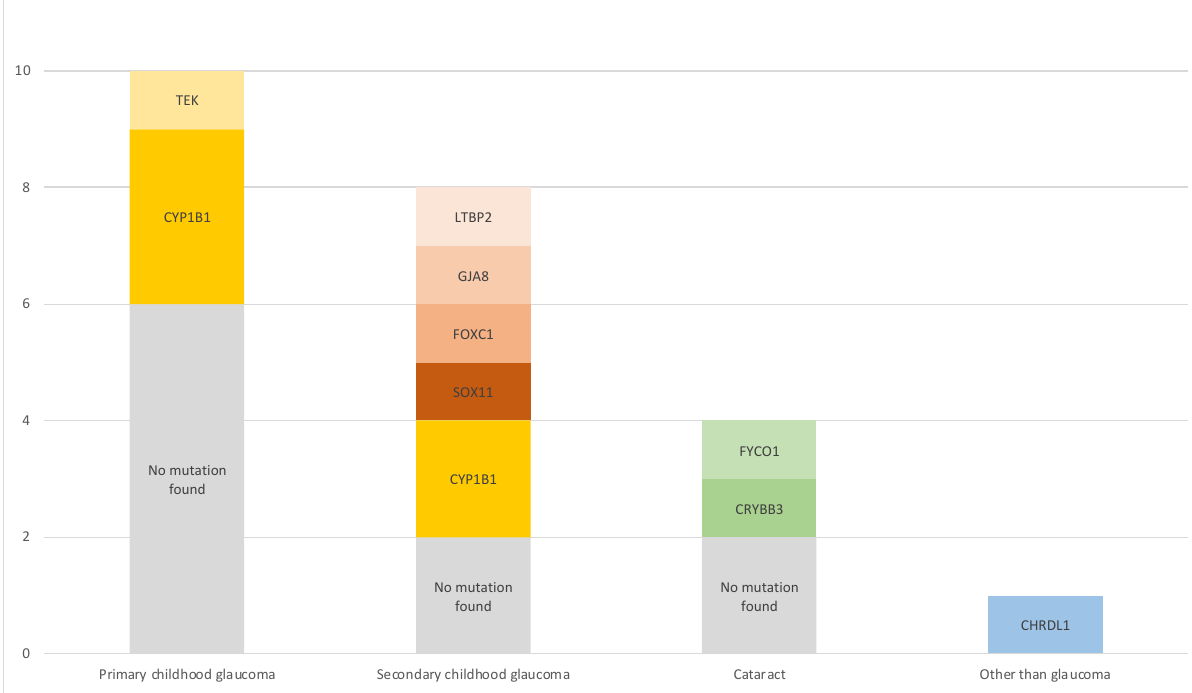
Figure 1. Phenotype–genotype relationship. Cases with missing results were excluded.